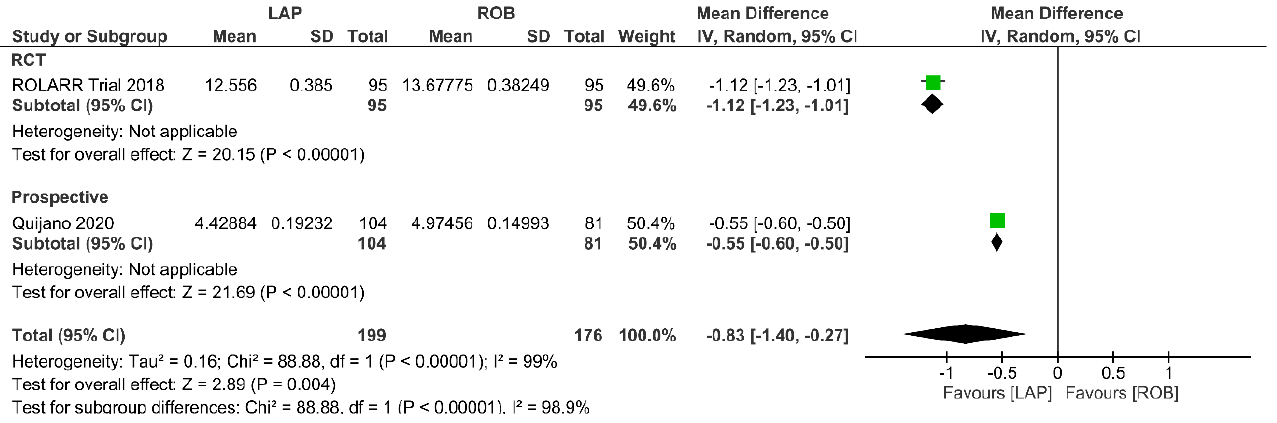
Figure 14. Forest plots comparing operative cost [19,34,53] between robotic and laparoscopic rectal resection (green boxes representing mean differences, arrows representing 95% confidence intervals, and diamonds representing point estimates of pooled odd ratios or mean differences).